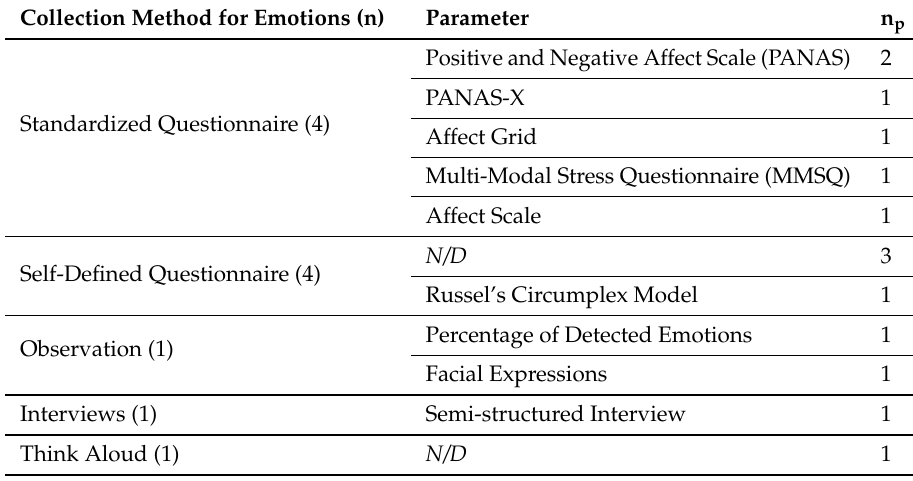
Table 14. Emotions collection methods and parameters.